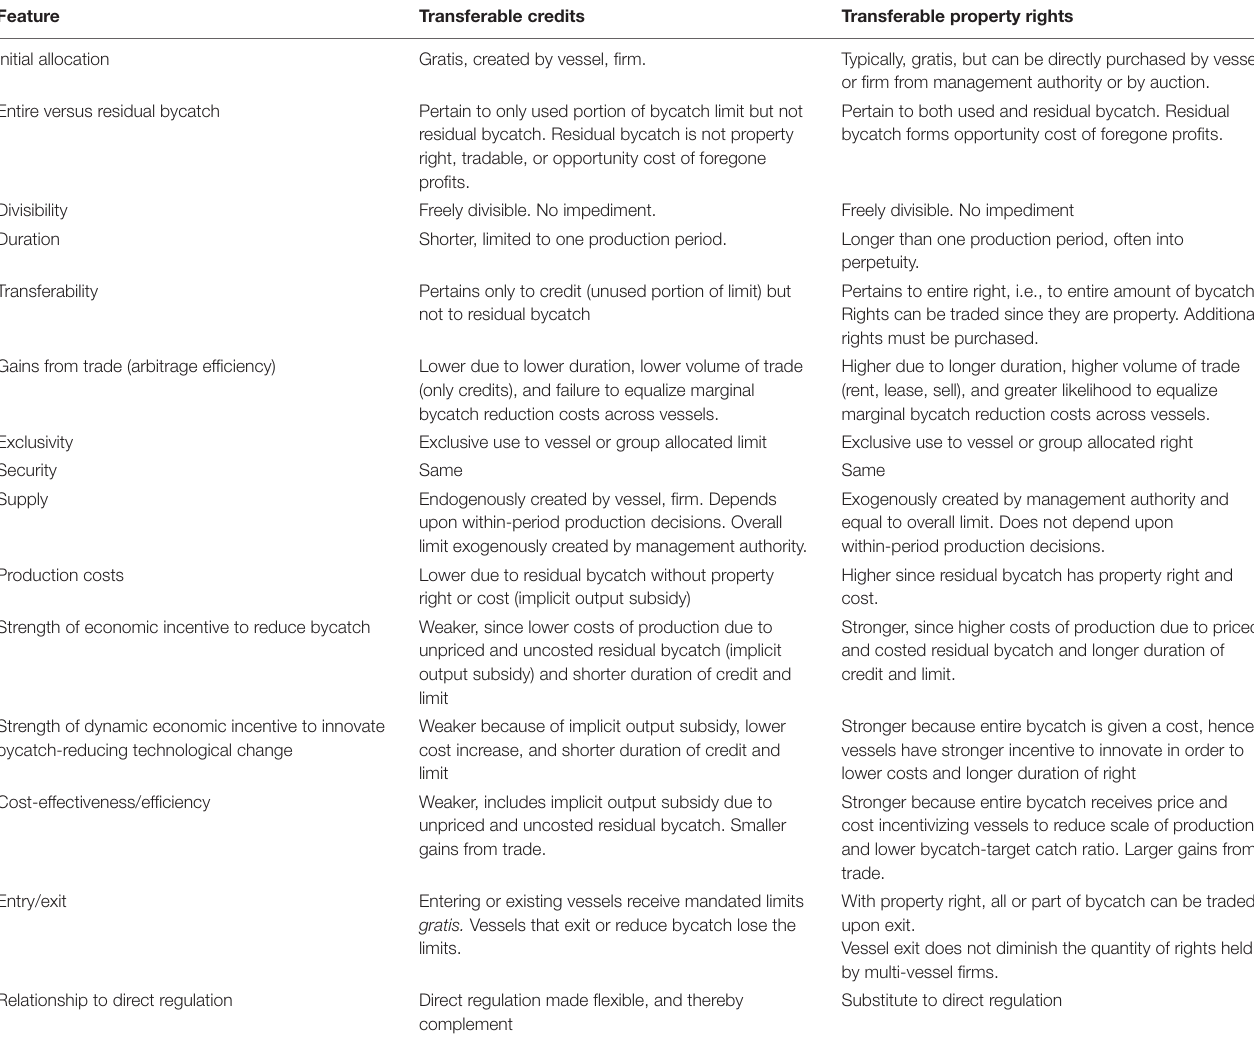
TABLE 2 | Cap-and-trade absolute transferable credits versus transferable property